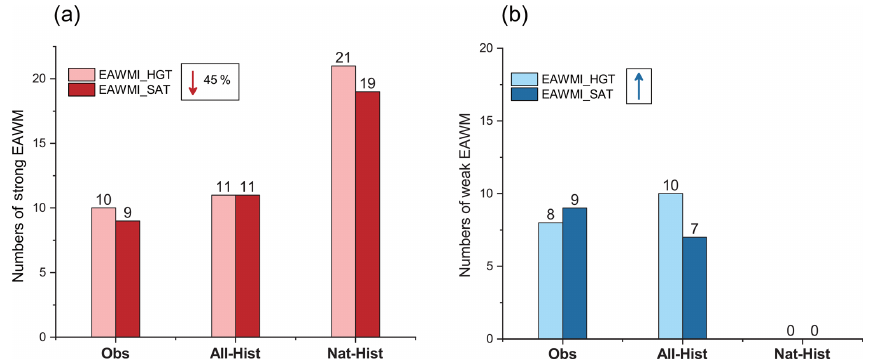
Figure 5. (a) The number of strong EAWM events during 1960–2012, based on the NCEP reanalysis dataset (left), outputs of models in the All-Hist runs (middle), and outputs of models in the Nat-Hist runs (right). (b) As in (a) but for weak EAWM events.